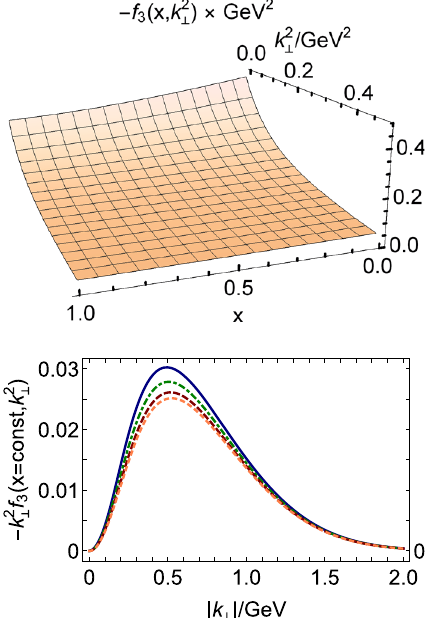
Fig. 10 Upper panel. Twist-three pion TMD, ˆ f ⊥ ( x , k 2 ⊥ ) , Eq. (75). Lower panel. k 2 ⊥ ˆ f ⊥ ( x , k 2 ⊥ ) at: x = 0 – solid blue curve; x = 1 / 4 – dot-dashed green curve; x = 1 / 2 – dashed dark-red curve; and x = 3 / 4 – short-dashed orange curve. Scale is ζ H , Eq. (61)